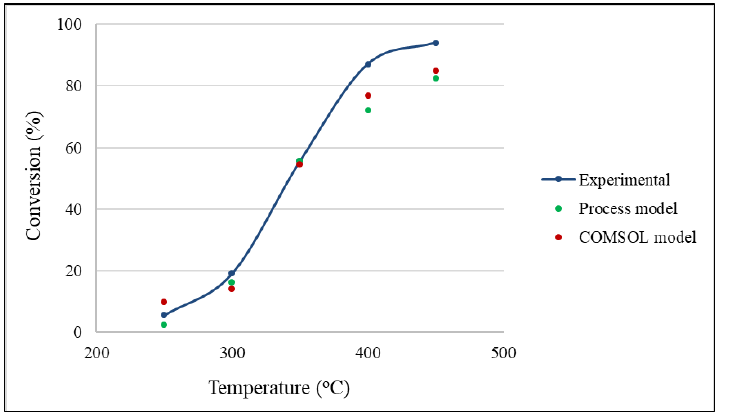
Figure 1. Comparison between the experimental and modelling findings. Reaction conditions: Pres- sure, 300 psig; gas phase, hydrogen; liquid phase, 4-propylguaiacol; liquid flow rate, 0.03 mL ∙ min −1 ; gas flow rate, 0.09 mL ∙ min −1 .